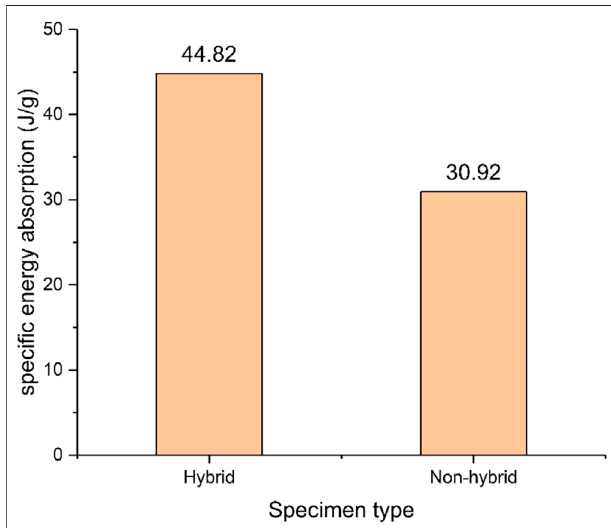
FIGURE 9 | A comparison of SEA between nonhybrid and hybrid composite specimen.